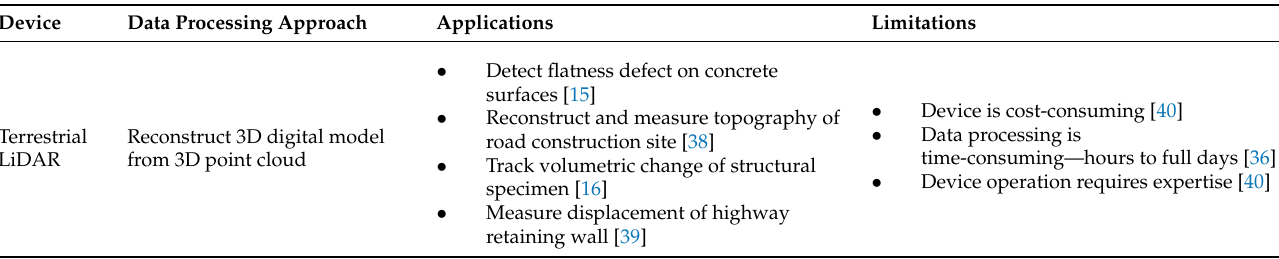
Table 1. The list of literature